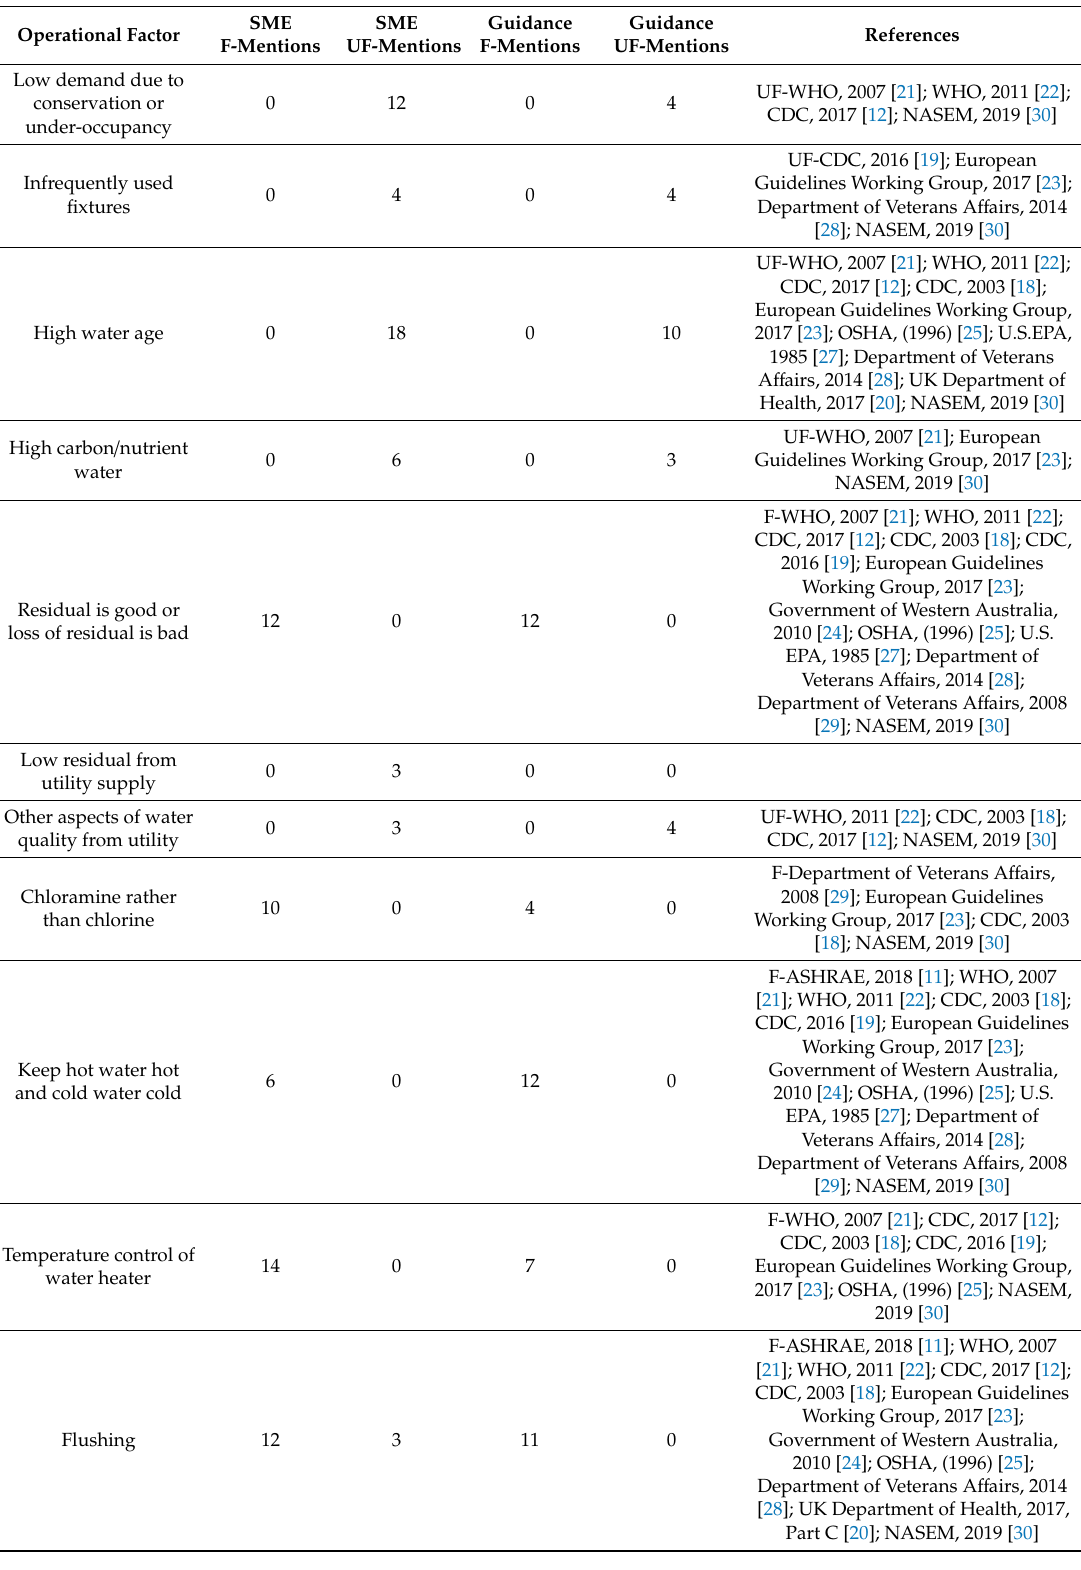
Table 3. Summary of the favorable and unfavorable views of SMEs and guidance documents on various premise plumbing operational factors. F—favorable and UF—unfavorable